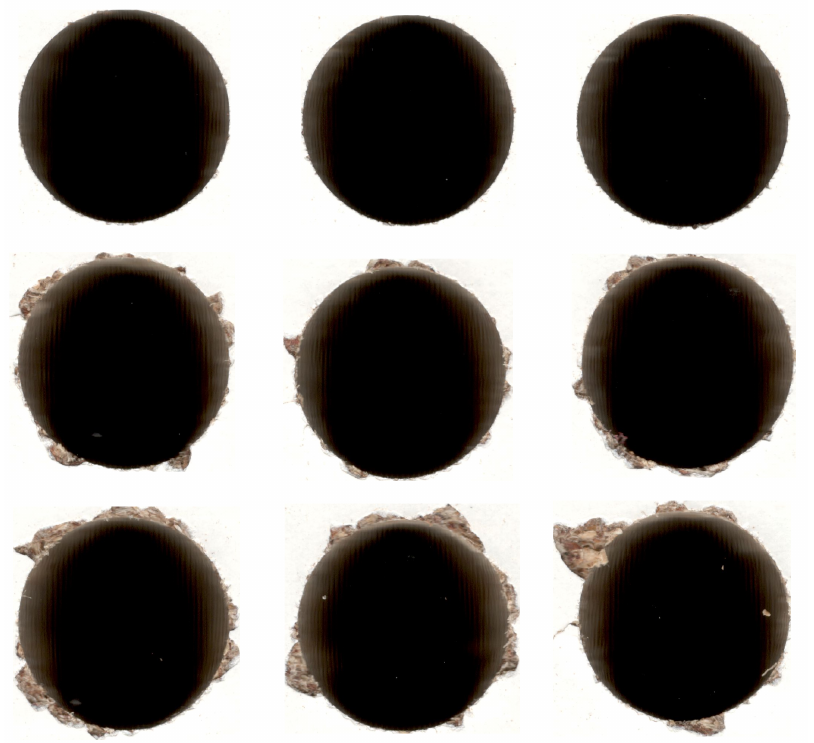
Figure 2. Images obtained after initial processing which are used as an input to the main procedure: green ( top ), yellow ( middle ), and red ( bottom